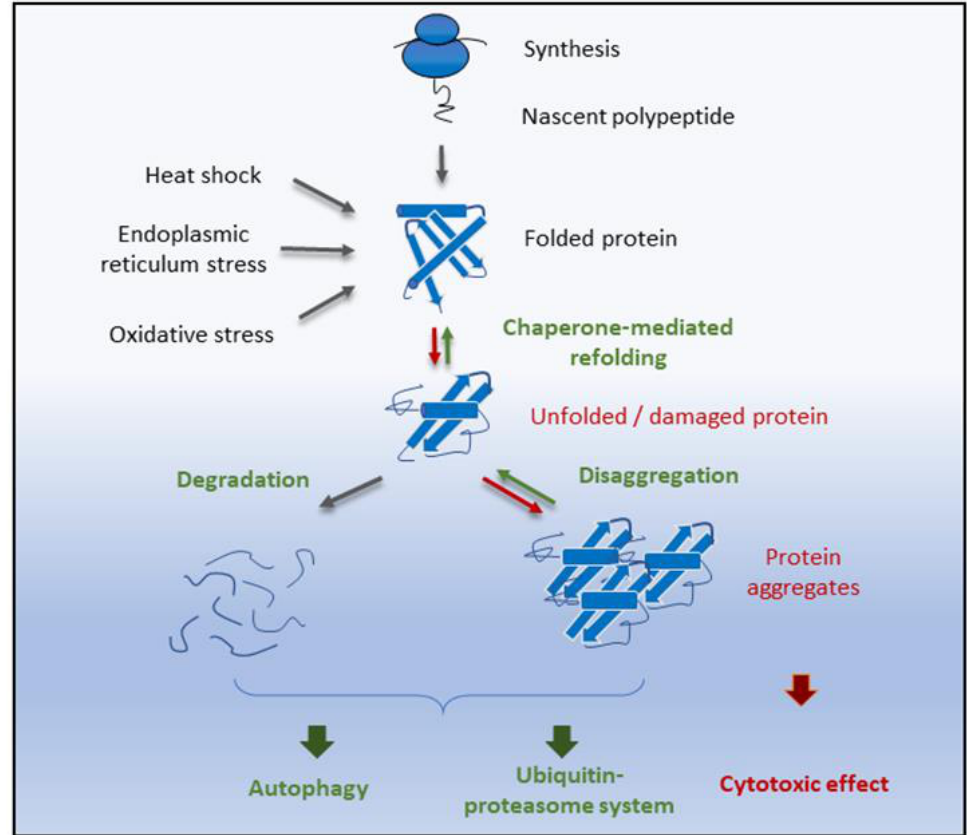
Figure 1. Pathways of proteostasis under stress conditions. Under normal conditions, misfolded proteins are degraded and / or cleared extracellularly, undergo autophagy, or are degraded with the aid of the cellular proteasome. Endogenous and exogenous stress conditions contribute to cellular dysfunction, protein misfolding, and protein aggregations that lead to the loss of homeostasis. Unfolded and damaged proteins are refolded by heat shock proteins through the chaperone-mediated folding pathway, or they are destructed by ubiquitin–proteasome or autophagic pathways (micro- and macroautophagy). Deficiencies in refolding or degrading unfolded proteins can lead to the formation of toxic aggregation.